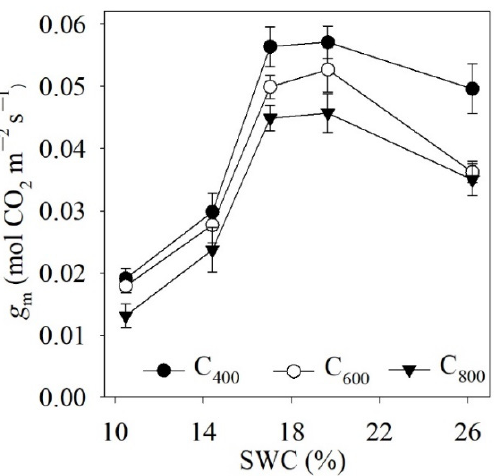
Figure 4. Response of measured leaf mesophyll conductance ( g m, mol CO 2 · m − 2 · s − 1 ) to three CO 2 concentrations ( C a ) × five soil water contents (SWC). C 400 , C 600 , and C 800 are C a of 400, 600, and 800 μ mol·mol − 1 . Data represent mean values ± SD.